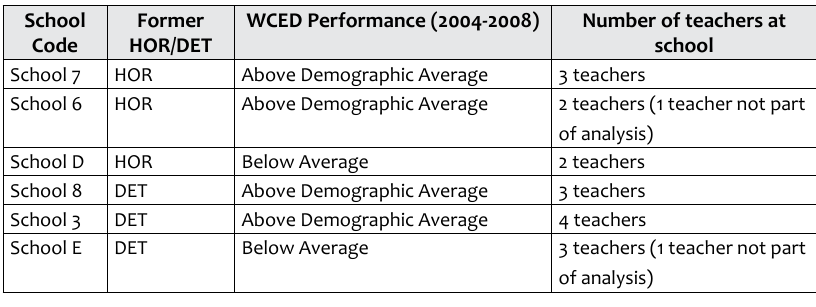
Table 1: Summary of data set used for